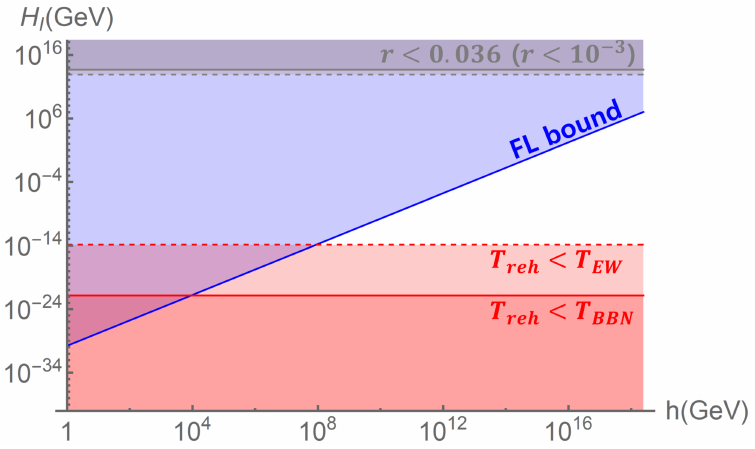
Figure 3 . Bound on inflation scale from FL bound depending on the location of Higgs vev. Only white colored region is